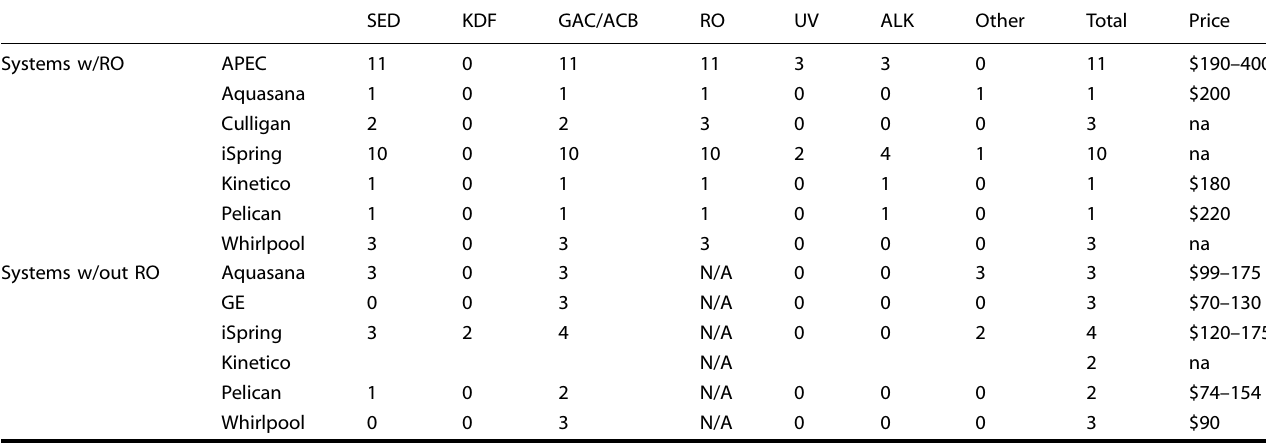
Table 12. Number of products using each treatment type in under-the-sink systems.